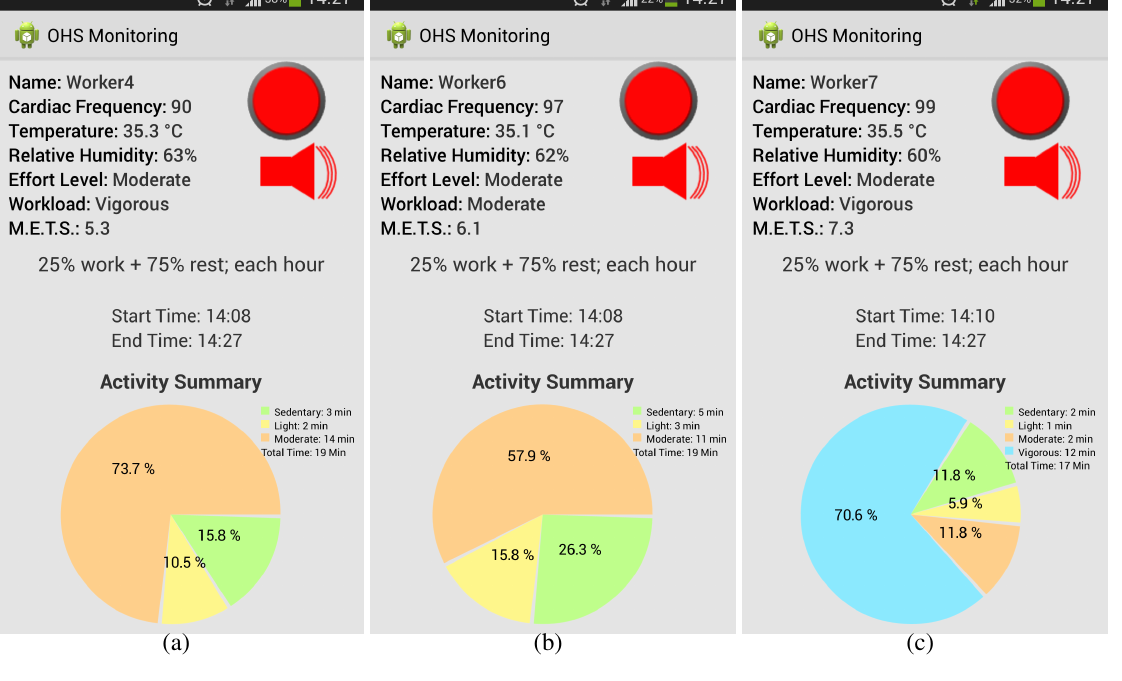
Figure 8. Estimated OHS levels in the afternoon: ( a ) OHS for Worker 4; ( b ) OHS for Worker 6; and ( c ) OHS for Worker